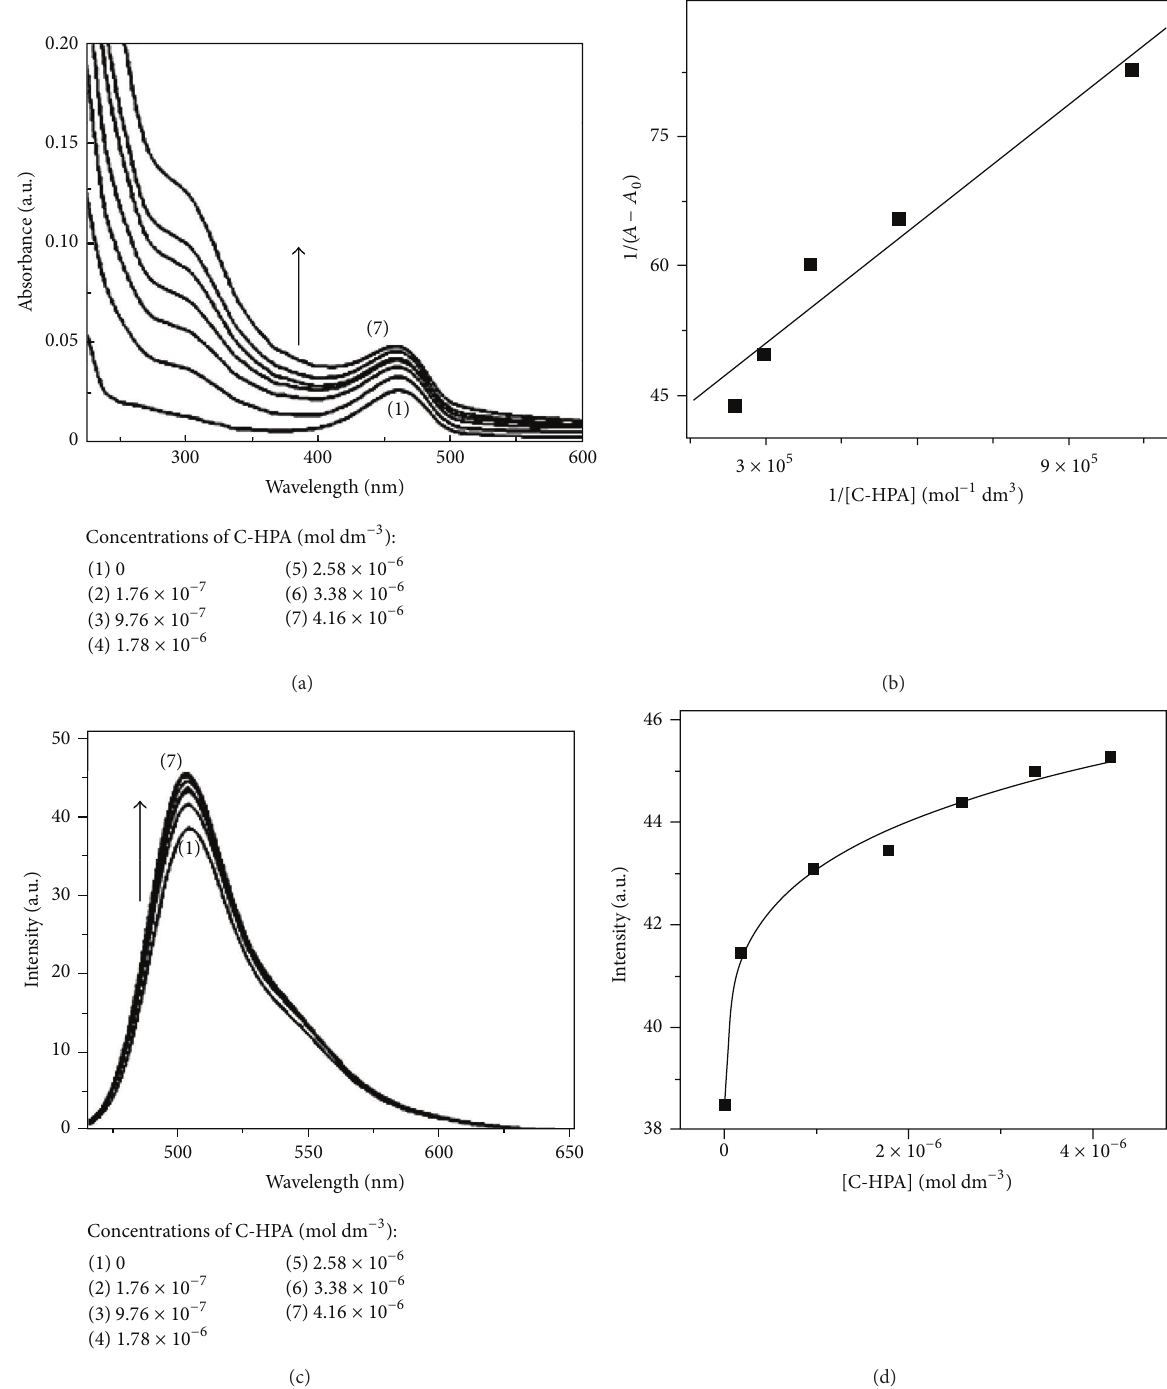
Figure 5: (a) Absorbance spectra of C334 with varying concentrations of C-HPA. (b) 1/ (𝐴 − 𝐴 0 ) versus 1/[C-HPA] plot of C334-C-HPA complex. (c) Fluorescence spectra of C334 at different concentrations of C-HPA. (d) Nonlinear plot for the increase in fluorescence intensity of C334-C-HPA